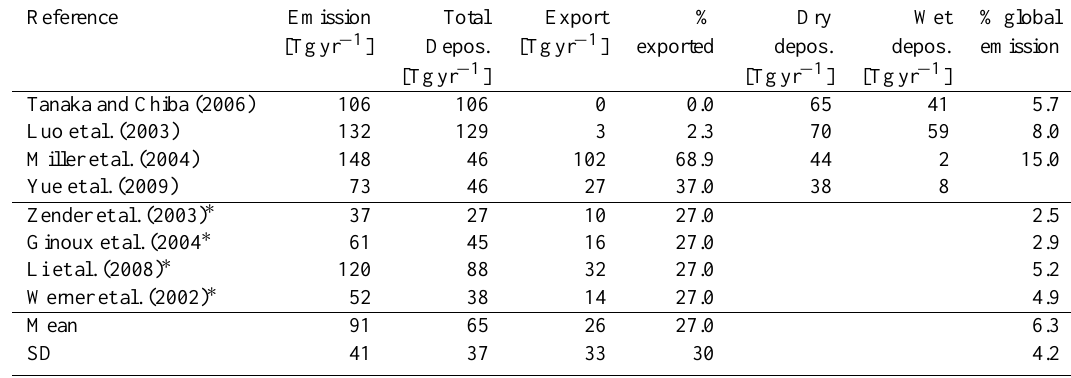
Table 5. Australian continental dust: annual emission, deposition, export and emission as % global emission. Reference